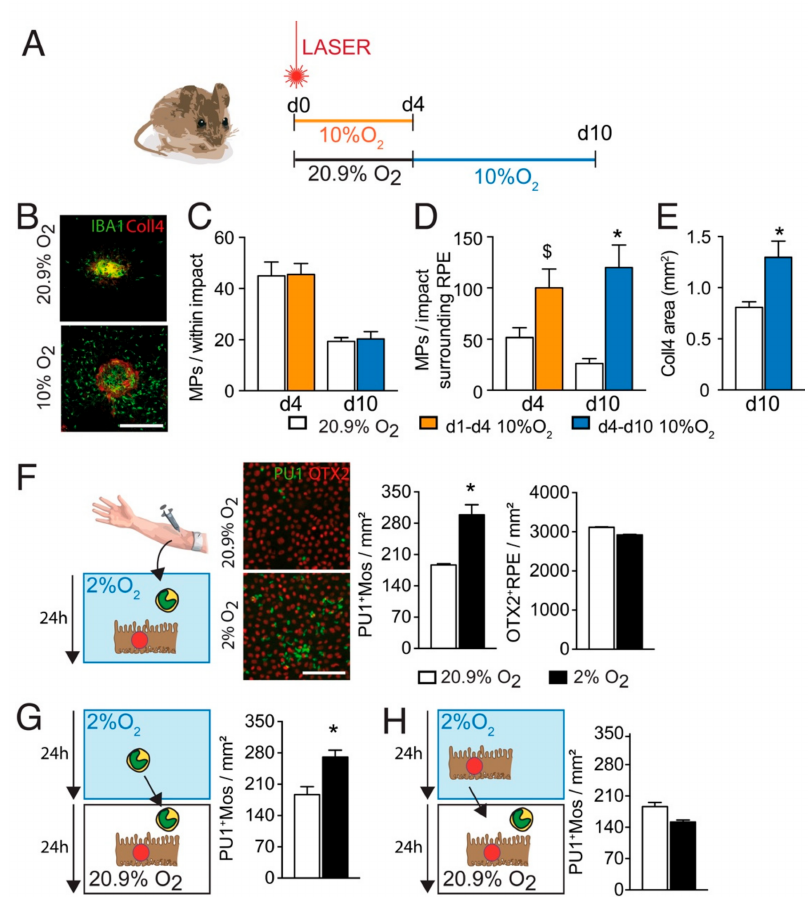
Figure 1. Hypoxia increases Mo resistance to RPE-induced elimination. ( A ) schematic representation of the experiments: mice were laser injured and either exposed to 10% O 2 hypoxia from d0–d4 and evaluated for the presence of subretinal IBA1 + MPs at d4 or exposed to 10% O 2 hypoxia from d4–d10 and evaluated for MPs and the extent of Collagen 4 + CNV at d10. Mice raised in normal 20.9% ambient O 2 served as controls. ( B ) Representative images of Collagen 4 (Coll4; red) and IBA-1 (green) immuno- stained RPE/choroid flatmounts of 10 days post laser-injured normoxic and hypoxic (d4–d10) mice. ( C , D ) Quantification of the density of subretinal IBA-1+ MPs per impact: ( B ) directly within the RPE-denuded lesion and ( C ) counted at a distance of 0–500 µ m to Coll4 + CNV on the apical side of the RPE surrounding the lesion at d4 and d10 of normoxic and hypoxia-exposed 2-month-old mice (room air white columns, 10% O 2 hypoxia d0-d4 orange columns; 10% O 2 hypoxia d4–d10 blue columns) ( n = 9–10 eyes; $ p = 0.0503; * p < 0.0001 Mann–Whitney versus their normoxic controls). ( E ) Quantification of the Coll4 + CNV surface at d10 of normoxia and hypoxia-exposed (d4–d10) laser- injured mice ( n = 9–10 eyes; * p = 0.0060 Mann–Whitney versus normoxic control). ( F ) Representative pictures of PU-1 OTX-2 co-stained co-cultures of PU1 + human monocytes (green) and OTX-2 + RPE cells (red) under normoxic-(20% O 2 ; white columns) and hypoxic-(2% O 2 ; black columns) conditions and their automated quantifications after 24 h co-culture ( n = 5 wells; * p = 0.0079 Mann–Whitney versus the normoxic condition), ( G ) quantifications of PU1 + human monocytes after 24 h of hypoxic (black column) or normoxic (white column) pre-incubation of Mo followed by 24 h of Mo/RPE coculture ( n = 5 wells; * p = 0.0079 Mann–Whitney versus the normoxic condition) ( H ) automated quantifications of PU1 + human monocytes after 24 h of hypoxic (black column) or normoxic (white column) pre-incubation of RPE followed by 24 h of Mo/RPE coculture. The in vivo results presented in ( B – E ) summarize two independently carried out experiments, the in vitro experiments ( F – H ) were repeated a minimum of five times and gave similar results. All values are reported as mean ± SEM. IBA-1: ionized calcium adapter molecule 1; Coll4: Collagen 4; PU1: hematopoietic transcription factor; OTX-2: Orthodenticle Homeobox 2; scale bar A = 400 µ m, E = 500 µ